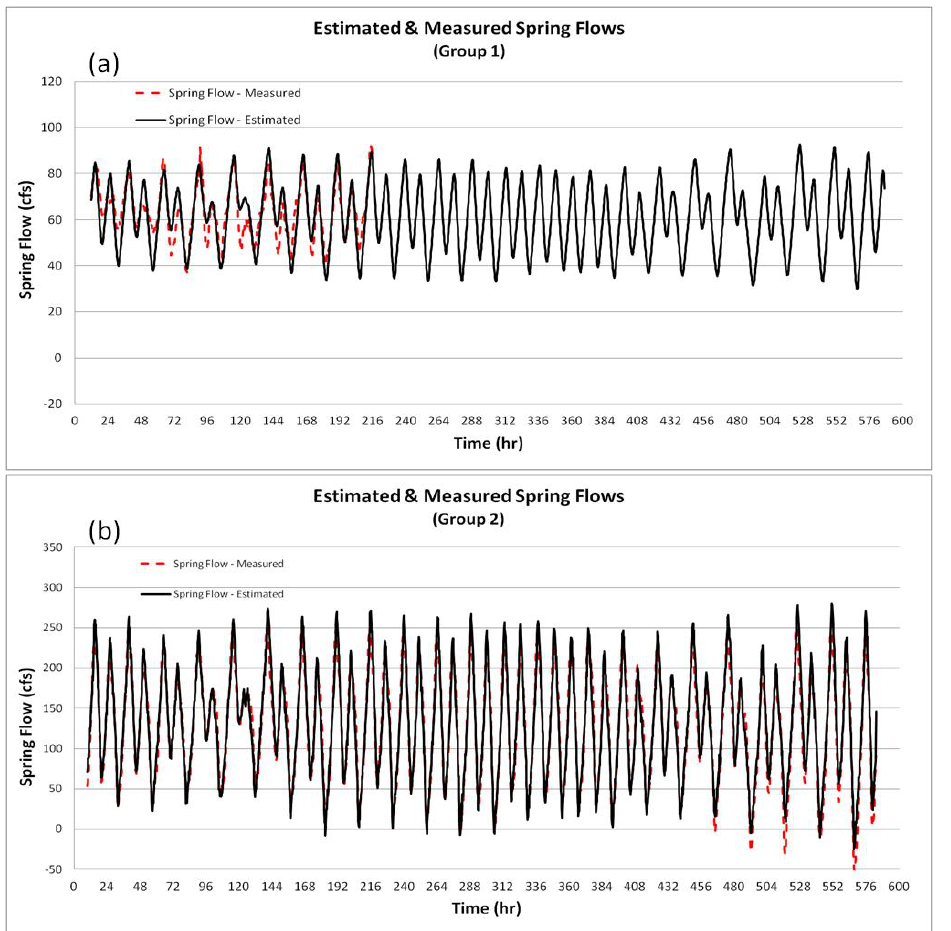
Figure 5. Time series of estimated and measured spring flows at G1 for Group 1 springs ( a ) and G2 for Group 2 springs ( b ) during 27 July–20 August